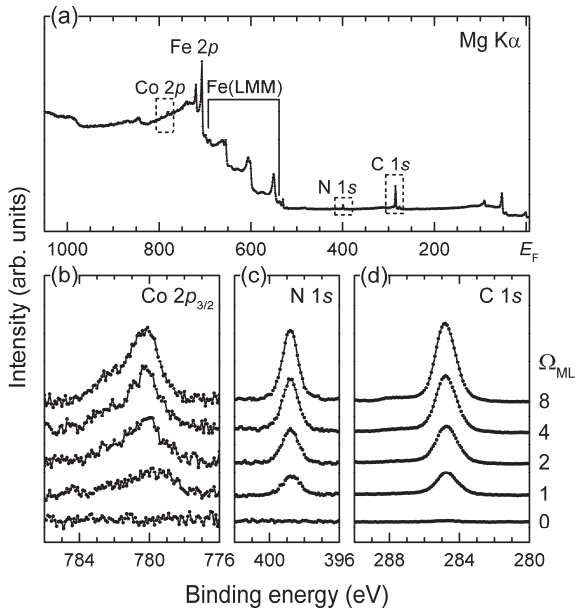
Fig. 2. (a) XPS wide scan (pass energy 40 eV) acquired on a 4 ML of CoTPP film. The Fe(LMM) label refers to the signal from Fe Auger electrons. (b-d) Detailed scans (pass energy 20 eV) acquired on CoTPP films of increasing thickness (Ω from 0 to 8 ML. A linear background is subtracted to the experimental data of panel (b), accounting for the signal coming from the Fe 2 p line located at lower BE [see panel (a)]. An integral (Shirley) background is subtracted in panels